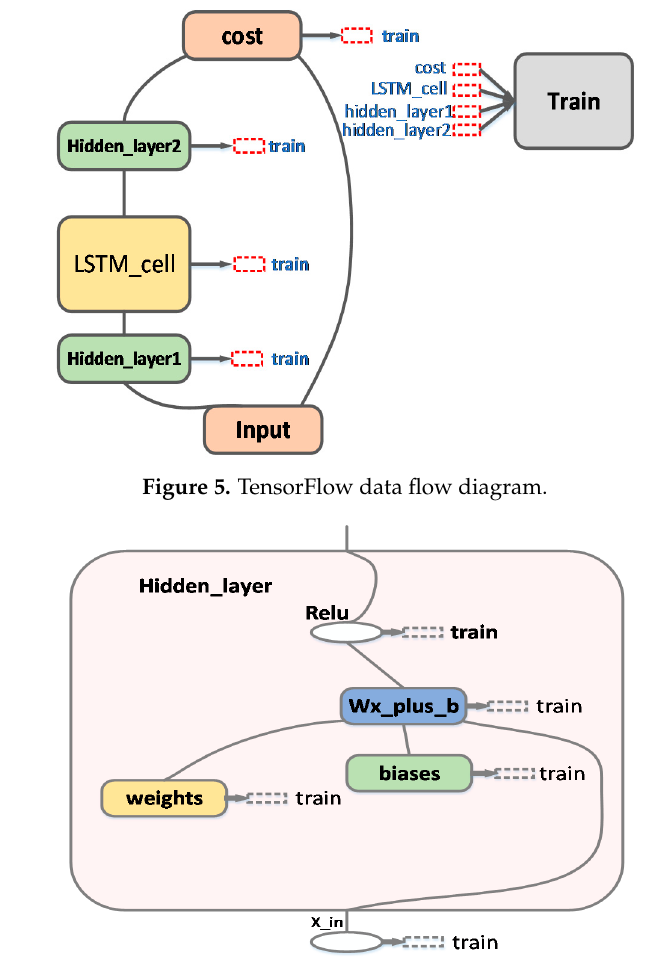
Figure 6. Data flow diagram of hidden layer in LSTM model.